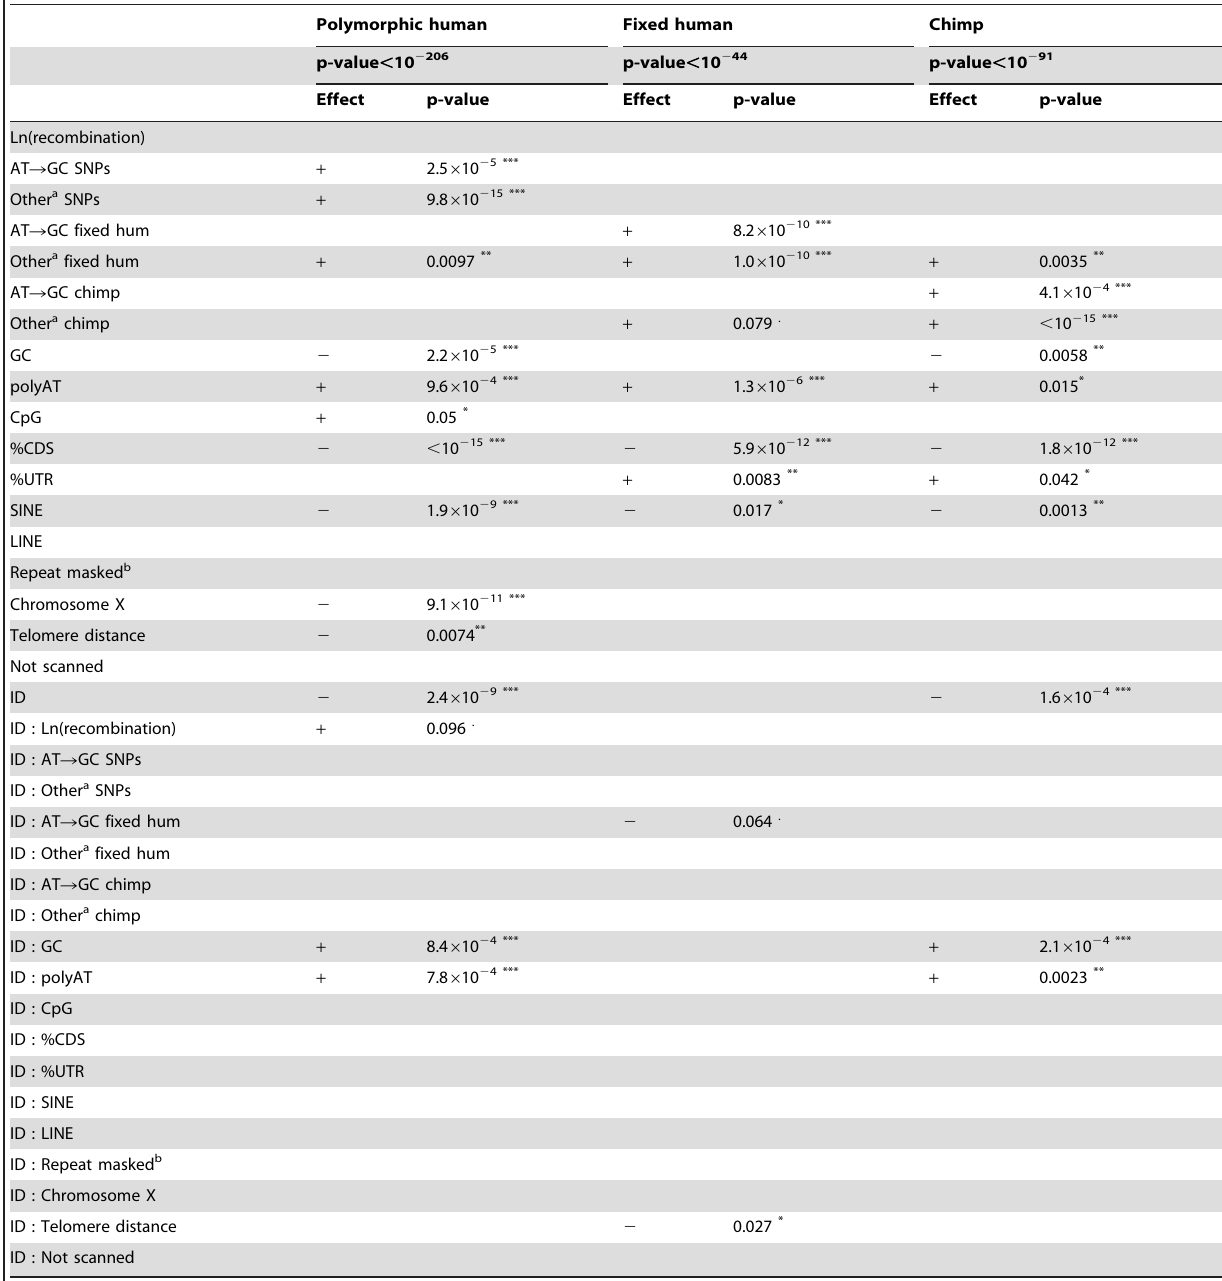
Table 5. Generalized linear model of